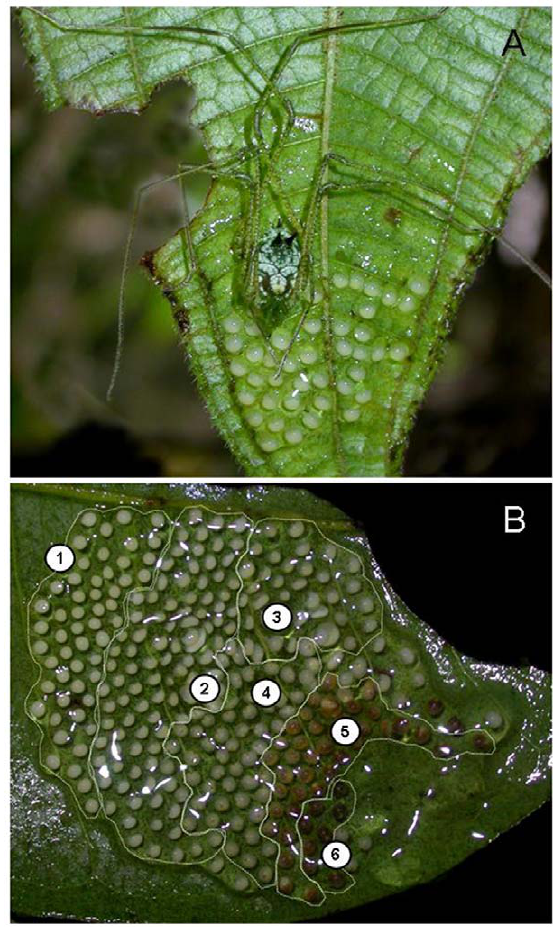
Figure 1. Paternal care in the harvestman Iporangaiapustulosa . (A) Male guarding eggs on the undersurface of a leaf. (B) Egg-batch composed of multiples clutches in different stages of embryonic development (see text for definition of each stage). Note that the eggs are covered by a thick mucus coat.